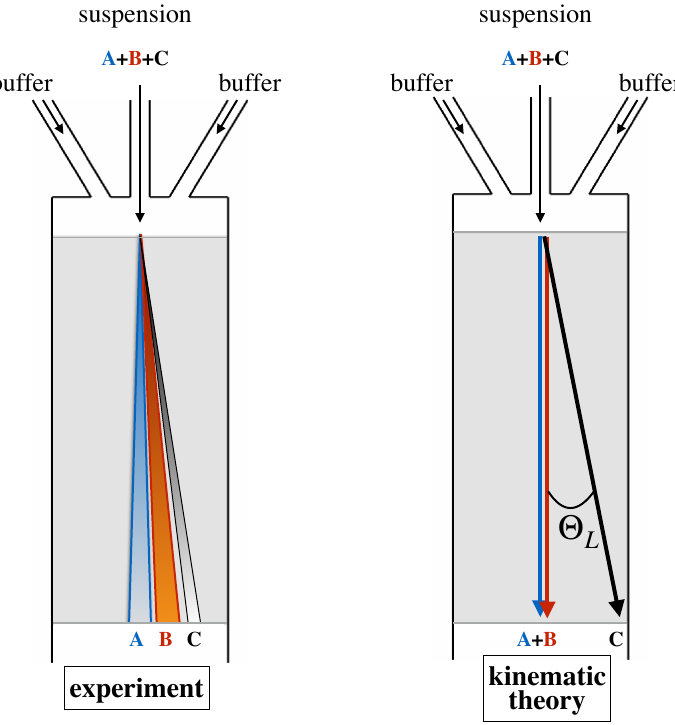
Figure 2. Comparison between experimentally determined behavior of particle transport in a DLD device and the prediction of the kinematic model. Particles “A” and “B” are smaller than the critical size, particle “C” is